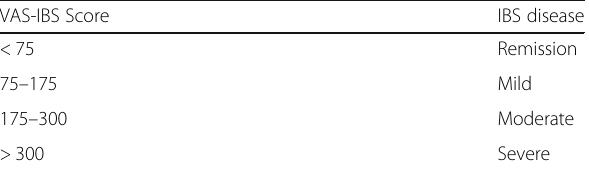
Table 2 VAS-IBS total score and relative trend of IBS disease VAS-IBS Score IBS